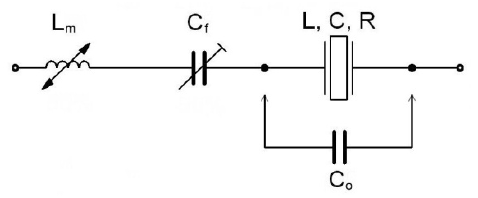
Figure 1. Compensation inductance L in series with the quartz